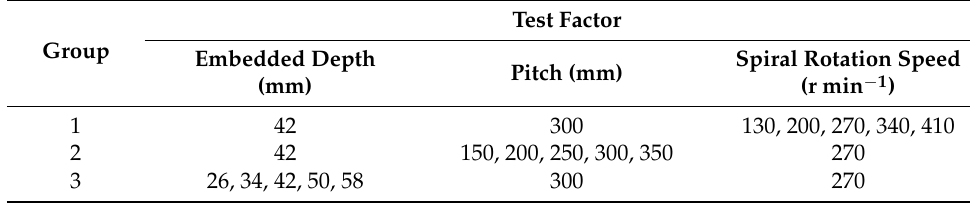
Table 2. Single factor experimental design.